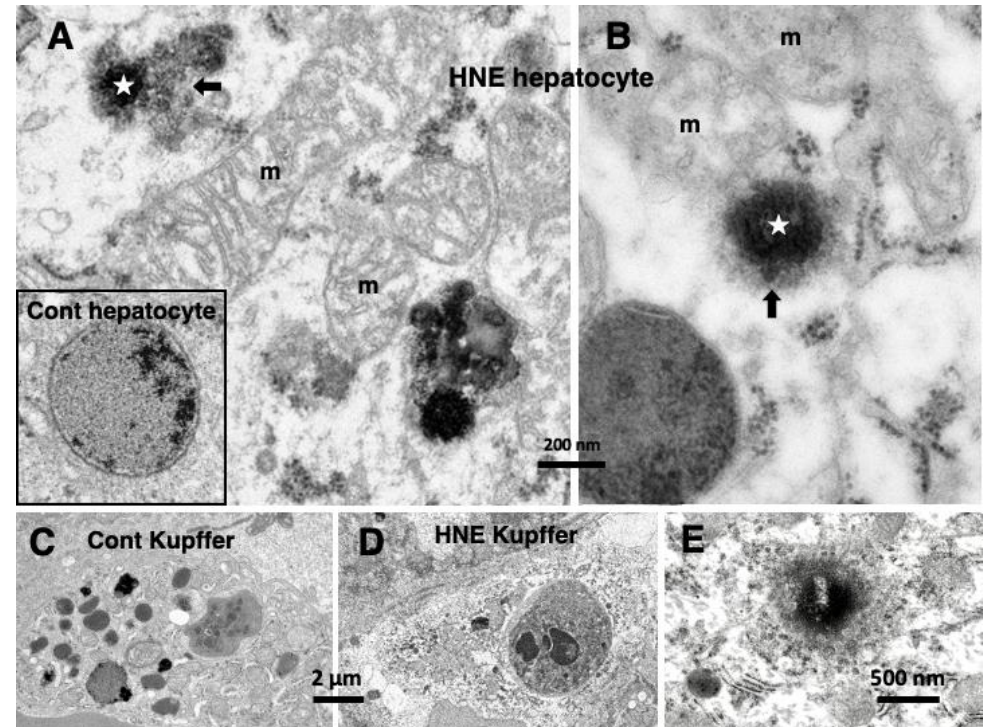
Figure 4. Electron microphotographs of a monkey liver after hydroxynonenal (HNE) injections ( A – D ) and the liver of human NASH patients ( E ). Compared to the membrane-bound lysosome of the control (( A ) rectangle), the monkey hepatocytes after the hydroxynonenal injections show permeabilization (( A , B ) arrows) of the lysosomal (stars)-limiting membrane. The degenerating lysosomes after hydroxynonenal injections often show shrinkage. Mitochondria show mild (( A ) m) or severe (( B ) m) disruption of the crista or double membrane, compared to the control. After the hydroxynonenal injections ( D ), lysosomal degradation is more severe in the Kupffer cells, compared to the sham-operated control ( C ). A liver biopsy specimen from a 60-year-old, female patient with NASH shows evidence of the lysosomal membrane permeabilization ( E ).